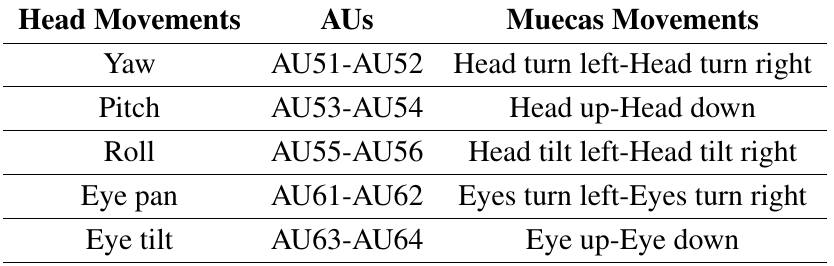
Table 6. Movements of the robotic head, Muecas, and the action units associated with the face tracking algorithm.